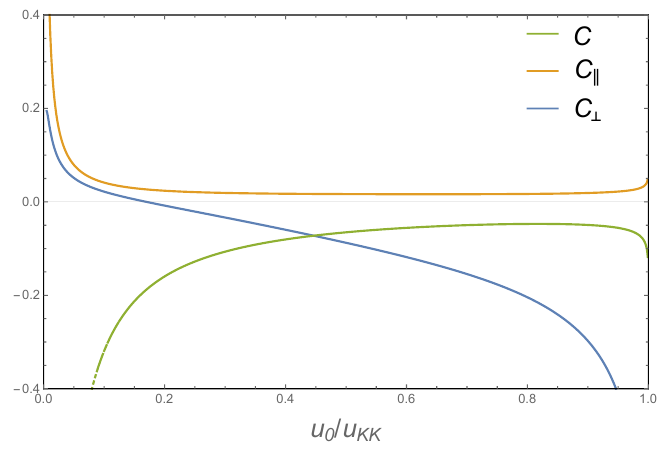
Figure 4 . The numerical constants C , C